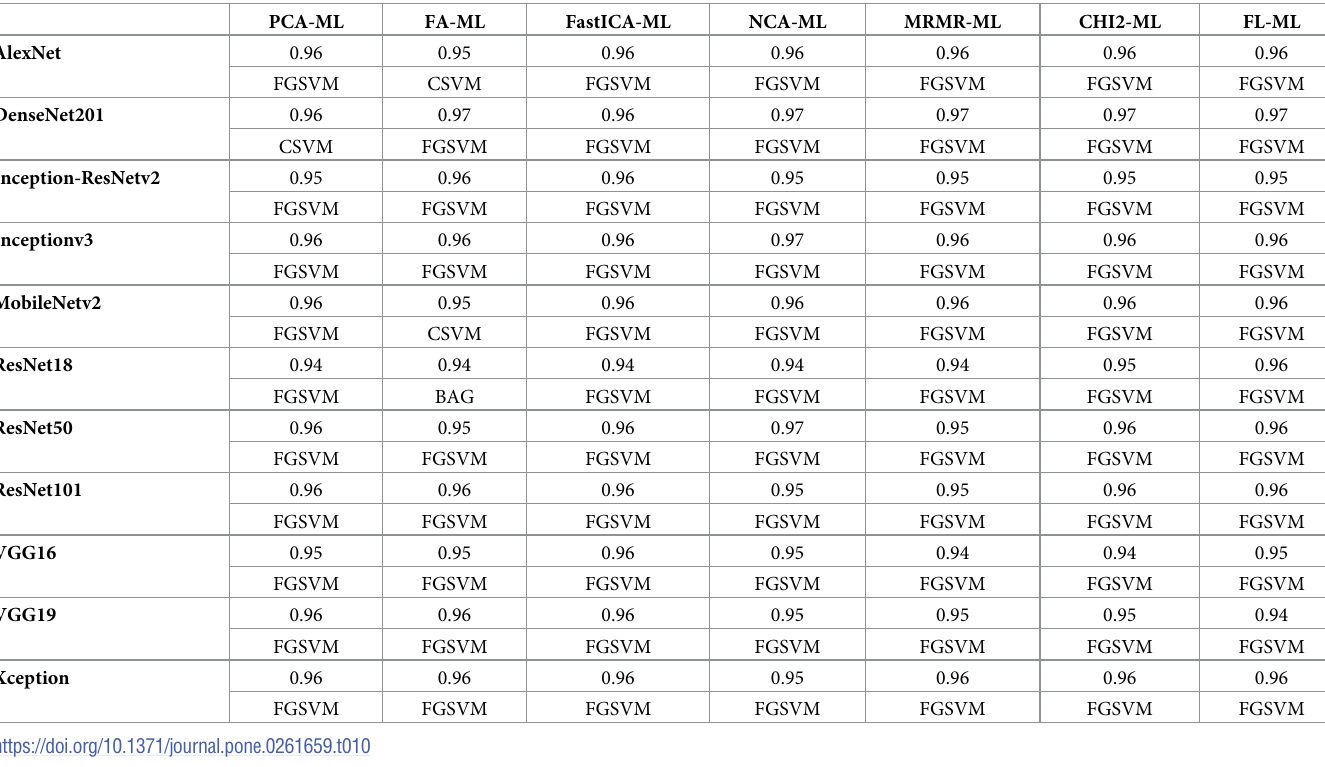
Table 10. The best ML learner for each combination method and its average classification performance (using F1-Score